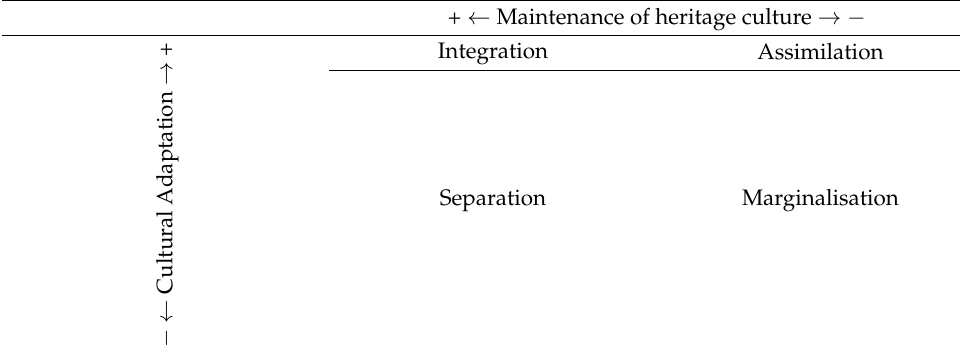
Table 2. Four possible outcomes from Berry’s Acculturation Model (Berry 1997,